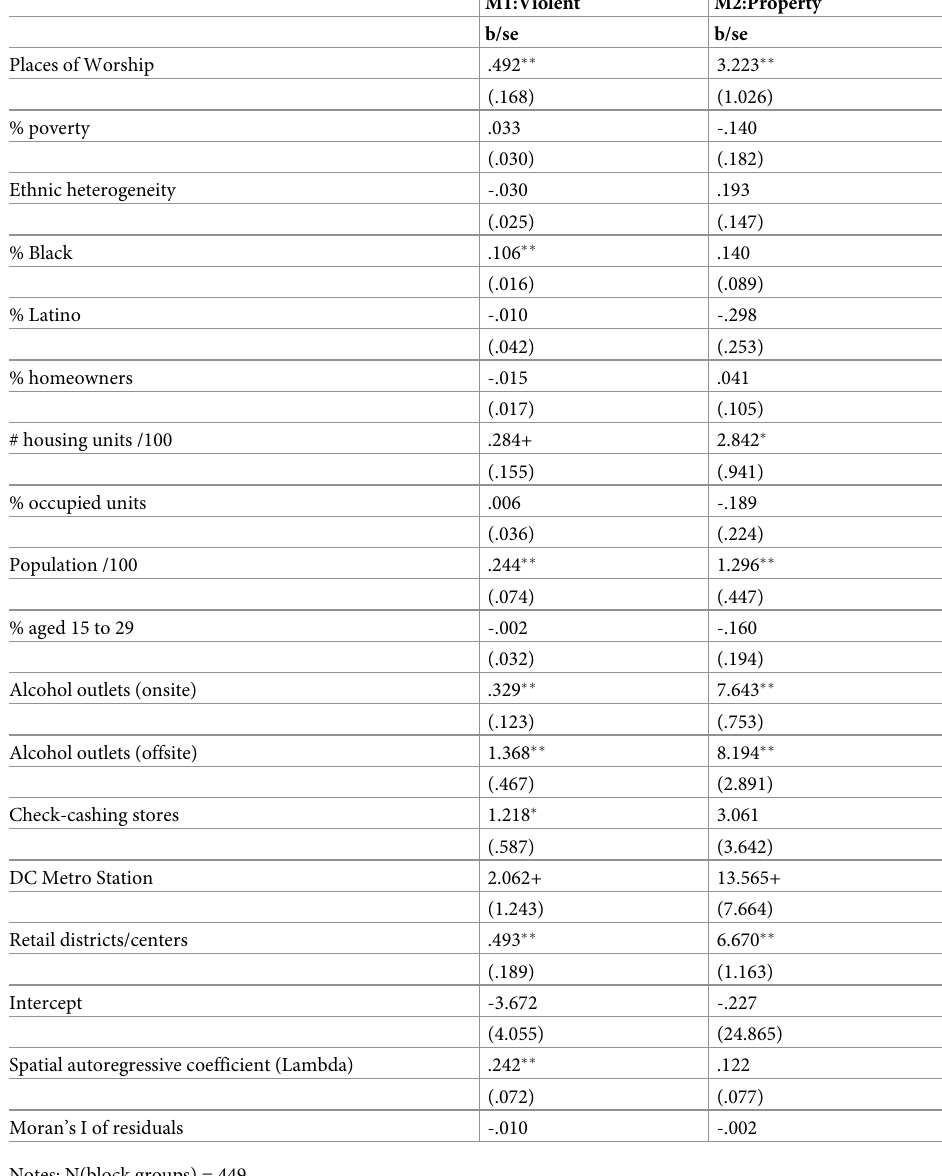
Table 6. Spatial error models, maximum likelihood estimation: POW effects on neighborhood